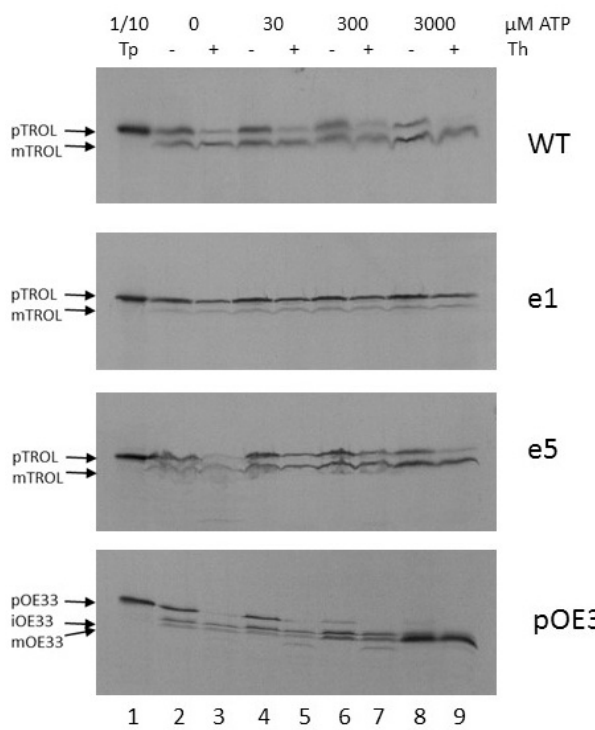
Figure 3. Energy requirement for import of wt TROL and its presequence mutants e1 and e5 into pea chloroplasts. Import into intact pea chloroplasts was performed under standard conditions, by incubating in vitro synthesized [ 35 S]-TROL, e1, e5, and control protein pOE33 from thylakoid lumen with chloroplasts corresponding to 20 µg chlorophyll at 25 ° C. ATP-scale import into intact pea chloroplasts was performed using increasing concentrations of ATP from 0 to 3000 µM. After import, chloroplasts were re-isolated on a Percoll cushion and samples were treated with 0.5 µg thermolysin (Th) per µg chlorophyll (lanes 3, 5, 7 and 9). Untreated samples are shown in lanes 2, 4, 6, and 8. The results were analyzed by SDS/PAGE. The respective precursor, intermediate, and mature forms are indicated by arrow heads. Lane 1 represents 1/10 of the translation product (Tp) used for the import reaction.